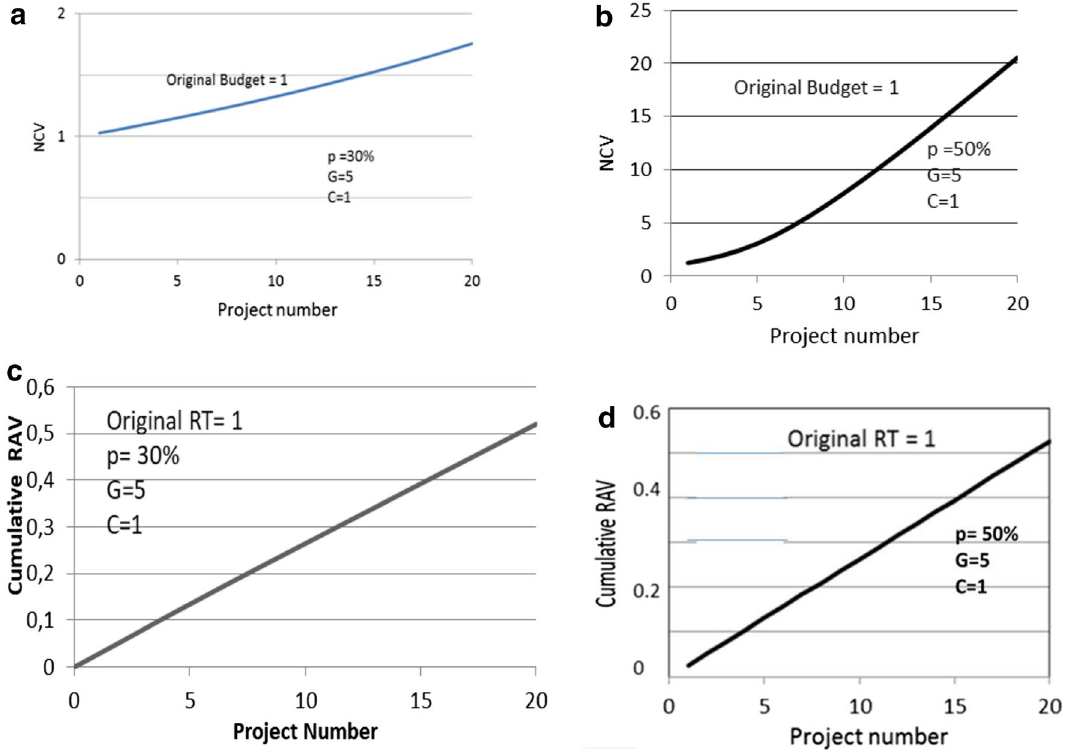
Fig. 5 Illustration of sequential evaluation for both the Kelly (Fig. 5a, b) and Cozzolino procedures (Fig. 5c, d) for success probabilities of 30% and 50% for